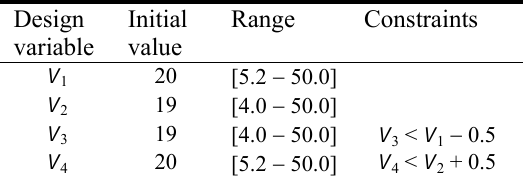
Table 1. Pipe cross section. Values of design variables